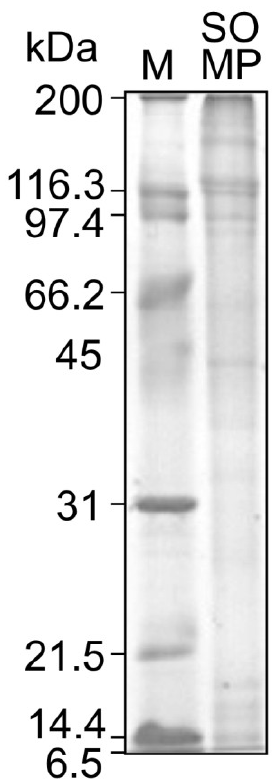
Figure 1. SDS-PAGE patterns of